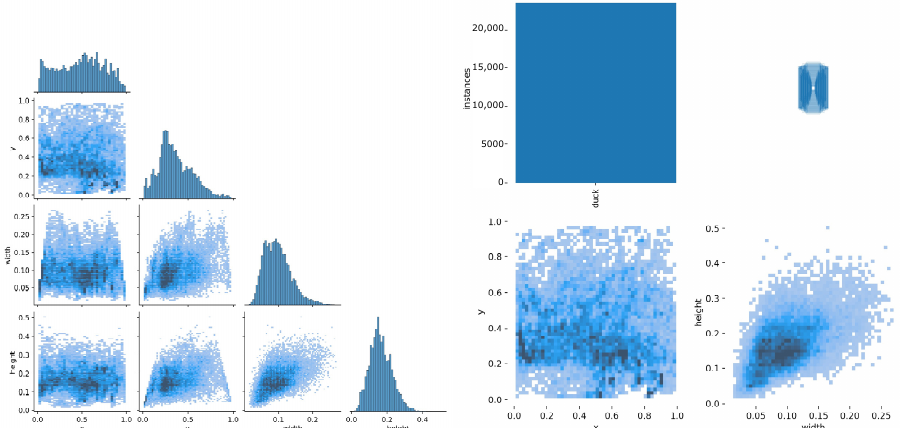
Figure 2. The distribution of ducks in the images of the dataset. x and y are the horizontal and vertical coordinates of the ducks located in the image. Width and height are the length and width of the ducks in the image. The distribution of the ducks’ positions follows a normal distribution in general. The position of the bounding box (both single-category and two-categories) for each duck in each image was marked by the researcher. The labeling of the bounding boxes follows the following principles: (1) the categories should be clear: for single-category tar- get detection, the category is set to duck, and for two-categories target detection, the cat- egory is set to both male and female; (2) in the case where the target individual is obscured, truncated or blurred, the bounding box should be clearly defined: when the target indi- vidual is obscured or truncated, the bounding box should contain the key features of the target individual with no other individuals, and when the target individual is blurred, the sample is still involved in training to improve the robustness of the model; (3) boundary check after annotation: it is necessary to ensure that the bounding box coordinates are not on the image boundary to prevent out-of-bounds errors during data enhancement. The process of acquiring the dataset is shown in Figure 3: